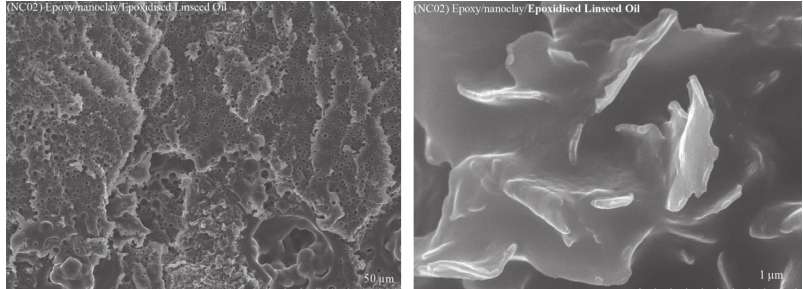
Figure 4: FE-SEM of the sample nanocomposites: epoxy Epikote 240/nanoclay/epoxidised linseed Oil/Sb